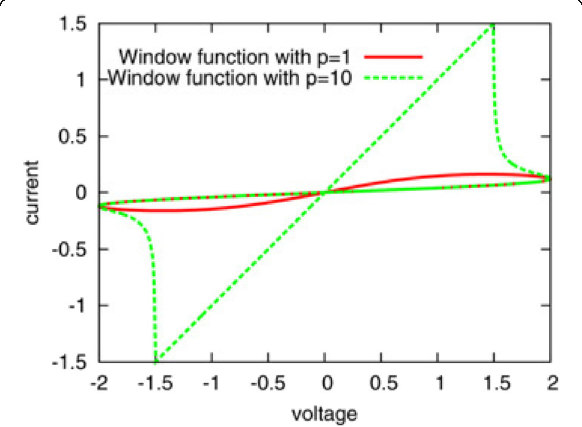
Fig. 20 Theoretical i - v curves for a memristor with (realistic) dopant drift modeled by window functions F p ( x )=(1 − (2x − 1)) 2p considering p =1 (red solid) and p =10 (green dashed). An external voltage v ( t )=2v 0 sin( ω 0 t /2) is applied. The memristor parameters are w 0 / D =0.5 and R OFF / R ON =50. The memristive behavior at p =10 has been enhanced. The slope of the i - v curve at a small time period is the same, R 0 − 1 , in both cases whereas the slope on return sweep depends on the window function. For a large p value, the return-sweep slope is R ON − 1 =1>> R 0 − 1 , corresponding to a fully doped memristor